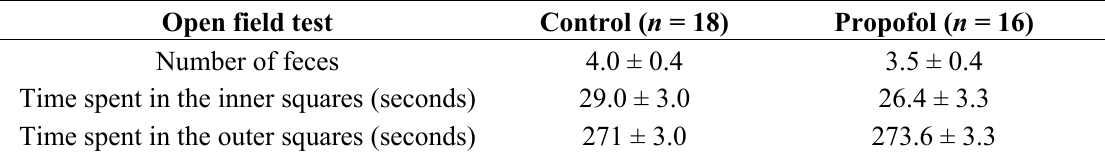
Table 2. Effect of prenatal propofol exposure on number of boli and time spent in the outer and inner squares in the open field